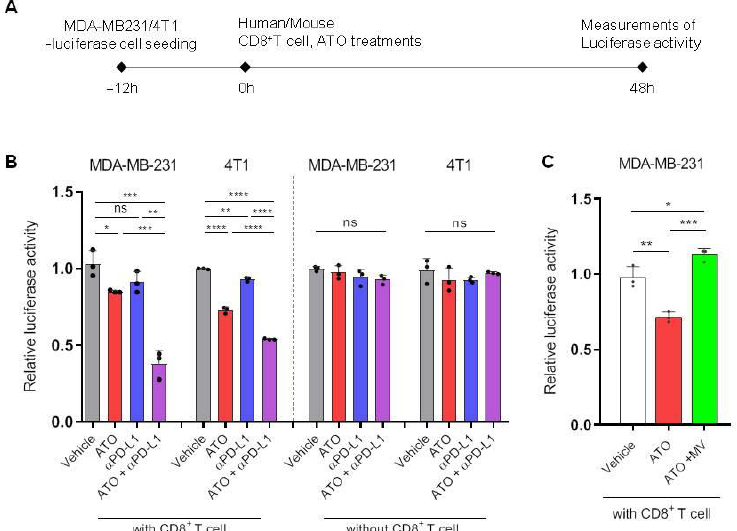
Figure 3. ATO combined with an anti-PD-L1 antibody enhances CD8 + T cell-mediated cytotoxic effects. ( A ) The experimental designs of the co-culture system to test CD8 + T-cell activity. ( B ) PBMC and mouse CD8 + T cell-mediated cytotoxicity in MDA-MB-231- and 4T1-luciferase cells following the indicated treatments ( n = 3) (left). Luciferase activity of the 4T1-luciferase cells without mouse CD8 + T cells ( n = 3) (right). ( C ) Mouse CD8 + T cell-mediated cytotoxicity of ATO reversed by the addition of MV. The results are presented as mean ± S.D. of three independent experiments. * p < 0.05, ** p < 0.005, *** p < 0.001, and **** p < 0.0001, respectively; NS, not significant.